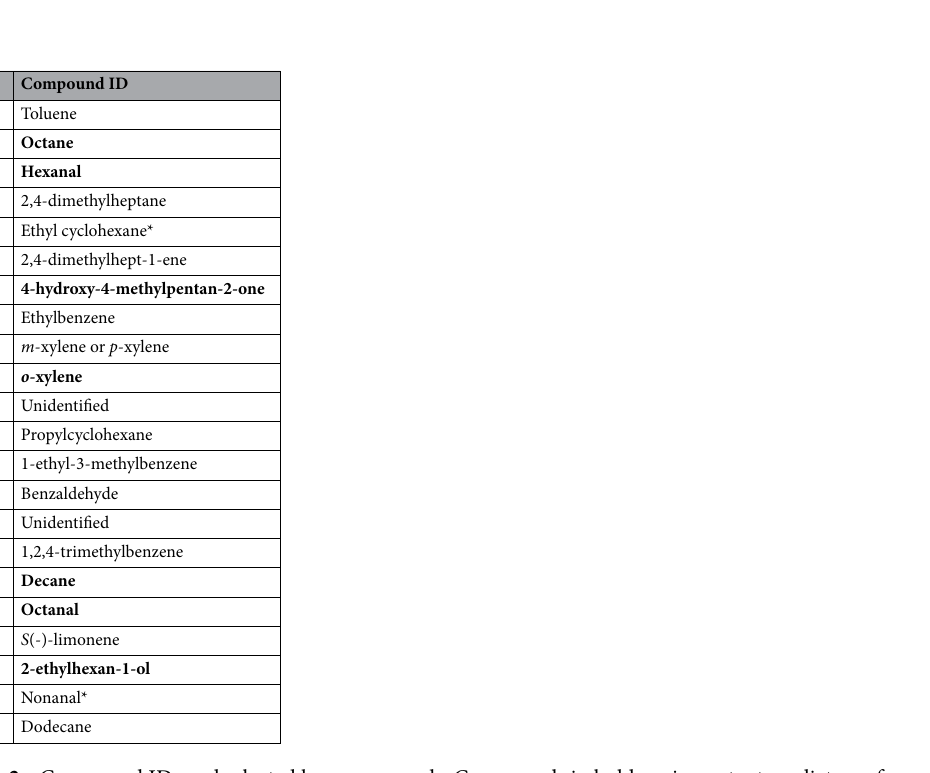
Table 2. Compound IDs and selected key compounds. Compounds in bold are important predictors of malaria status for children with fever/diarrhea. Asterisks (*) indicate compounds that are key predictors of symptom presence/absence in children without